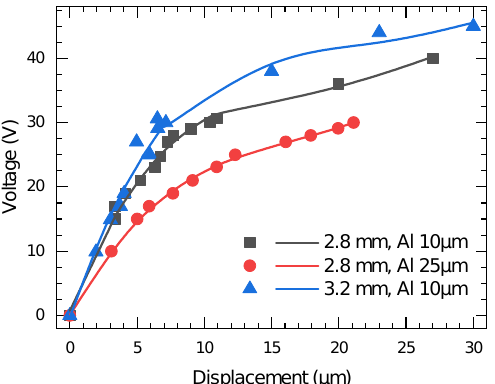
Figure 3. Experimental results of the measurements of the displacements of the PMs under energizing electrodes “1” and “2”: circular points (red color) and squared points (gray color) correspond to the PMs having the same side length of 2.8mm but different thicknesses of 25µm and 10µm, respectively; triangular points (blue color) correspond to the PM having a side length of 3.2mm and a thickness of